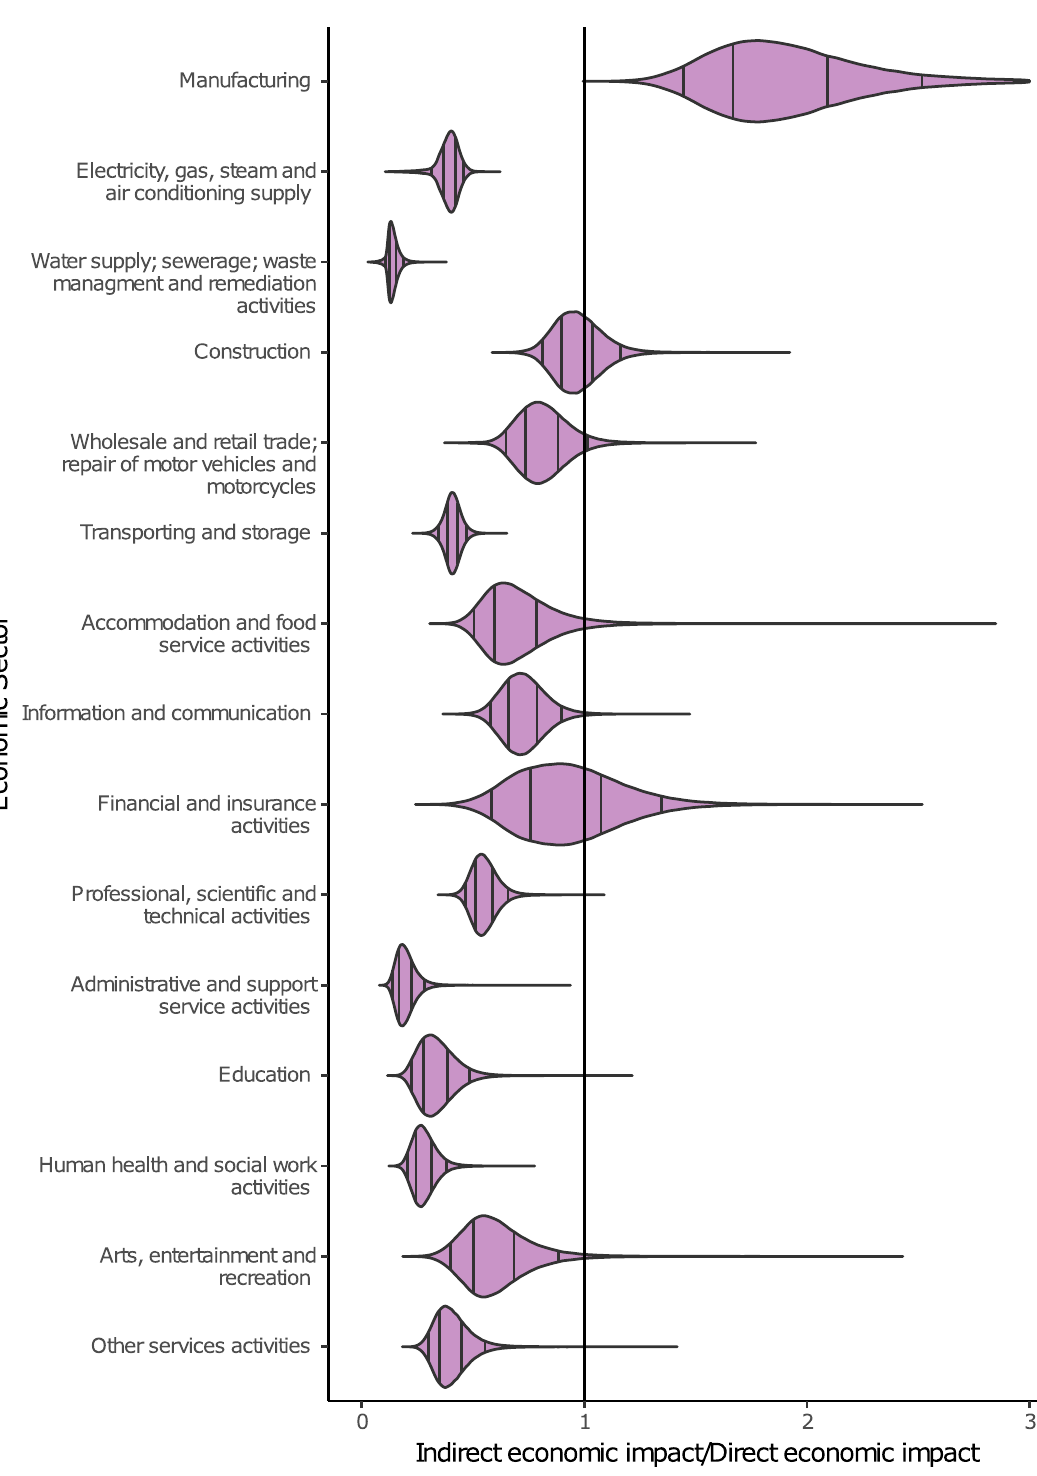
PLOS ONE | https://doi.org/10.1371/journal.pone.0212932 April 4,